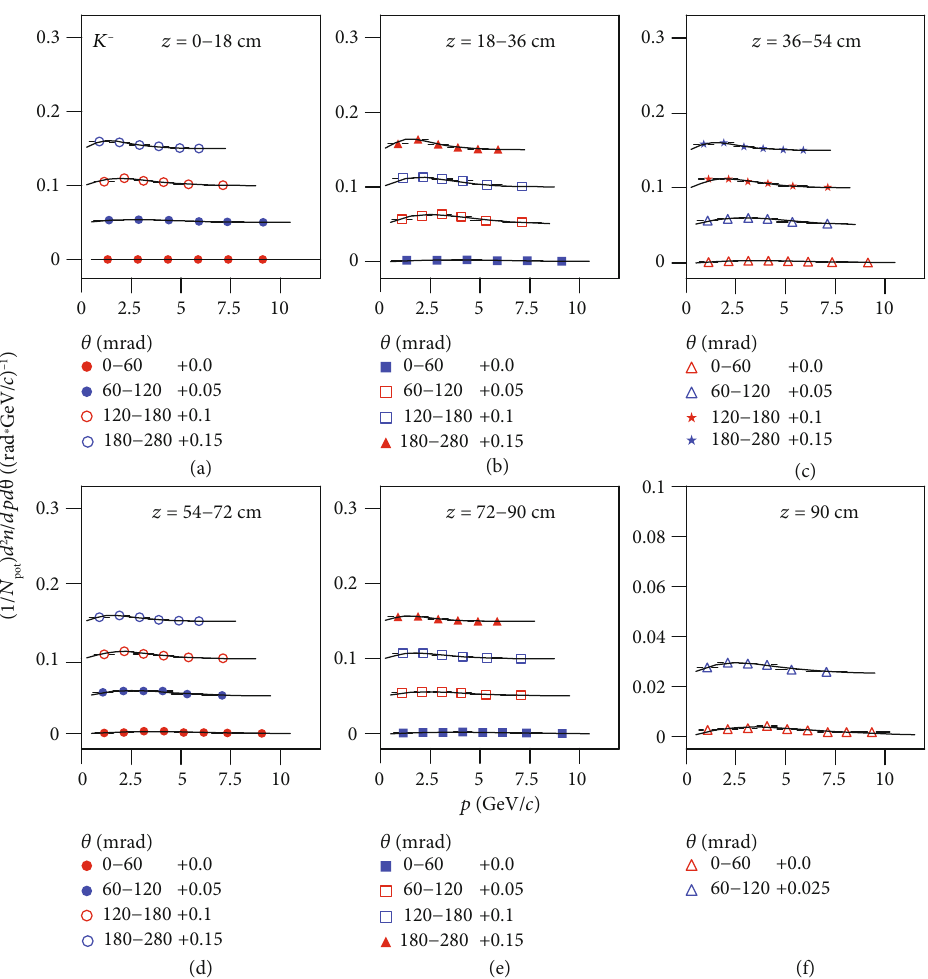
Figure 5: Same as Figure 1 but showing the spectra of K − . Panels (a – f) represent the spectra for z = 0 – 18, 18 – 36, 36 – 54, 54 – 72, 72 – 90, and 90cm,